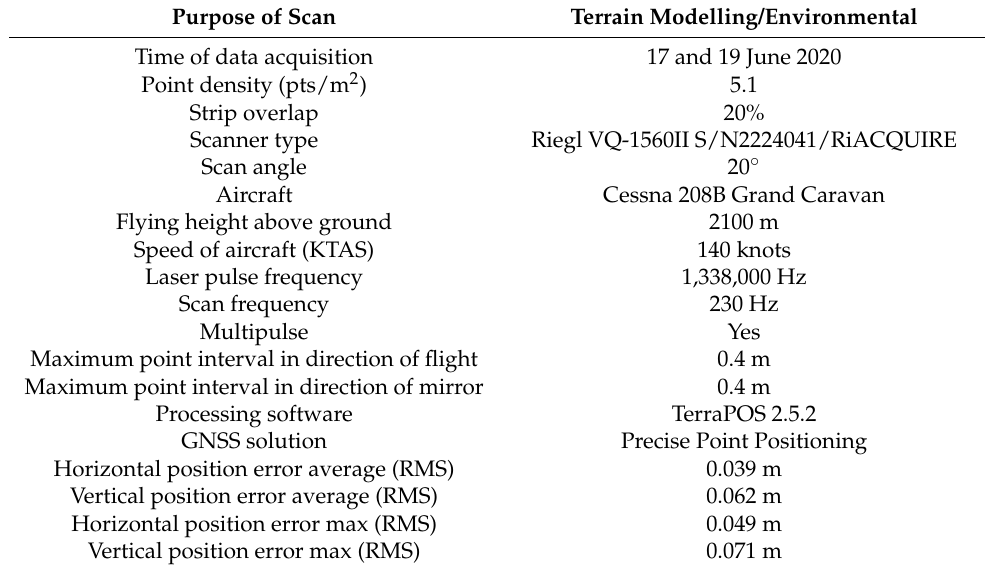
Table 3. Technical characteristic of the Ropijärvenperä production area ALS-5p data